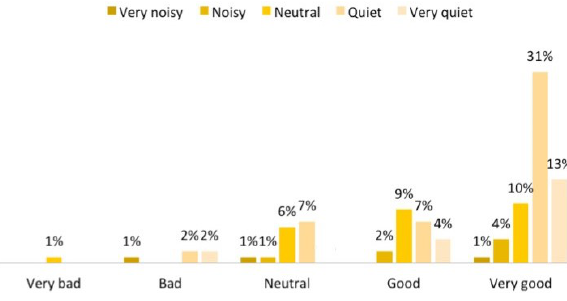
Figure 8: Diagram showing the consistent correlation between the level of quietness and sense of security, as both perceived by the app users in the “everyday quiet areas” © A. Radicchi 2018